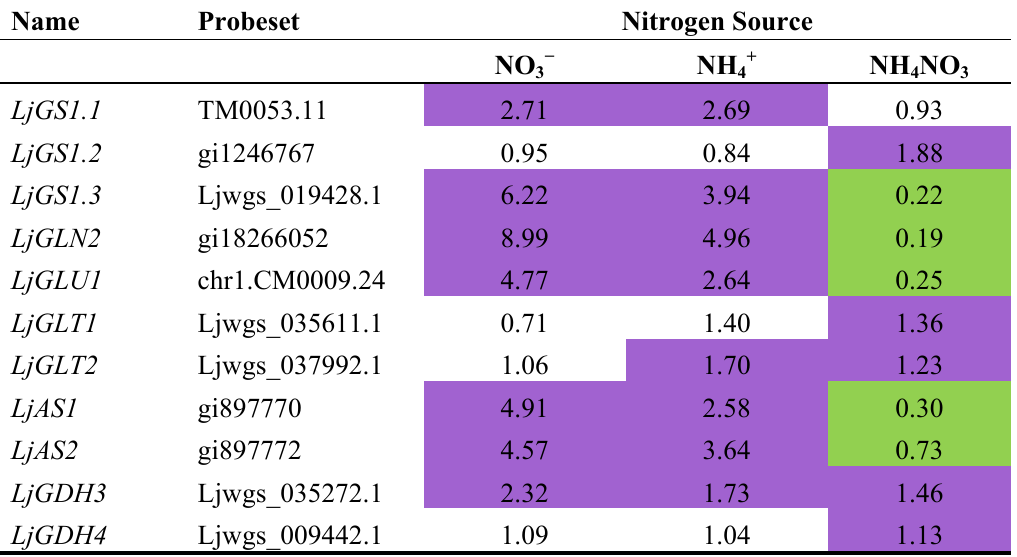
Table 3. Changes in the transcript levels for different isoforms of GS, GOGAT, AS and GDH in leaves of WT and Ljgln2-2 mutant plants grown in the presence of different nitrogen sources. Transcript levels were determined by qRT-PCR using three independent biological replicates. Data are reported as the ratio of transcript levels between Ljgln2-2 and WT plants, previously standardized to housekeeping genes. Genes that are more expressed in the mutant than in the WT, according to Student’s t test ( p < 0.05), are highlighted in purple, while boxes in green indicate significantly higher expression in the WT